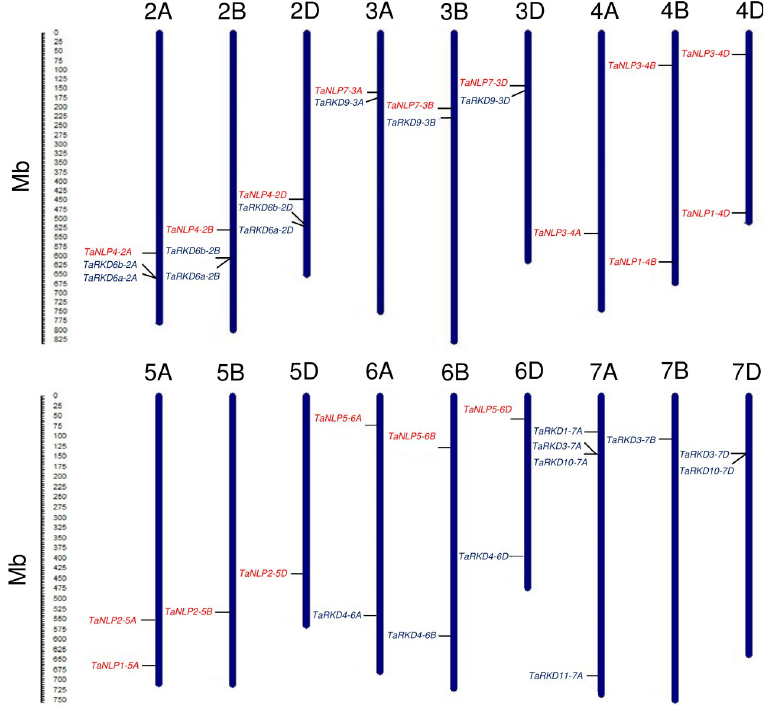
Fig 1. Distribution of 37 wheat TaRWP-RK genes (19 TaRKD and 18 TaNLP ) on 18 chromosomes belonging to six homoeologous groups. Chromosomes are represented by blue solid vertical bars. TaRKD genes are written in black and TaNLP genes are written in red